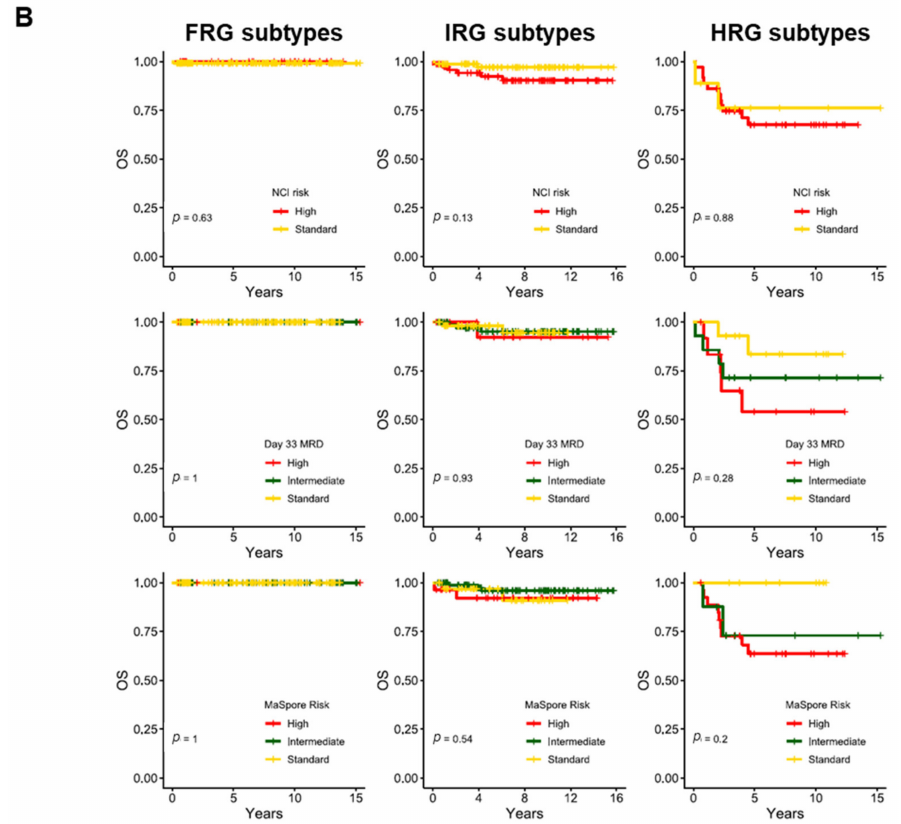
Figure 5. Treatment outcomes for genetic subtype risk groups with additional stratification by various prognostic markers in the Malaysia-Singapore cohort. ( A ) Event-free survival, and ( B ) overall survival. Genetic subtypes are defined by RNA-sequencing, and risk stratification is based on results from Malaysia-Singapore ALL trials. Favorable-risk (FRG) subtypes include hyperdiploidy and ETV6-RUNX1. Intermediate-risk (IRG) subtypes include DUX4, TCF3-PBX1, ETV6-RUNX1-like, ZNF384, ZNF384-like, PAX5alt, PAX5 P80R, IGH-CEBPE, NUTM1, and B-Others. High-risk subtypes (IRG) include TCF3-HLF, BCR-ABL, BCR-ABL-like, hypodiploidy, near-haploid, MEF2D,